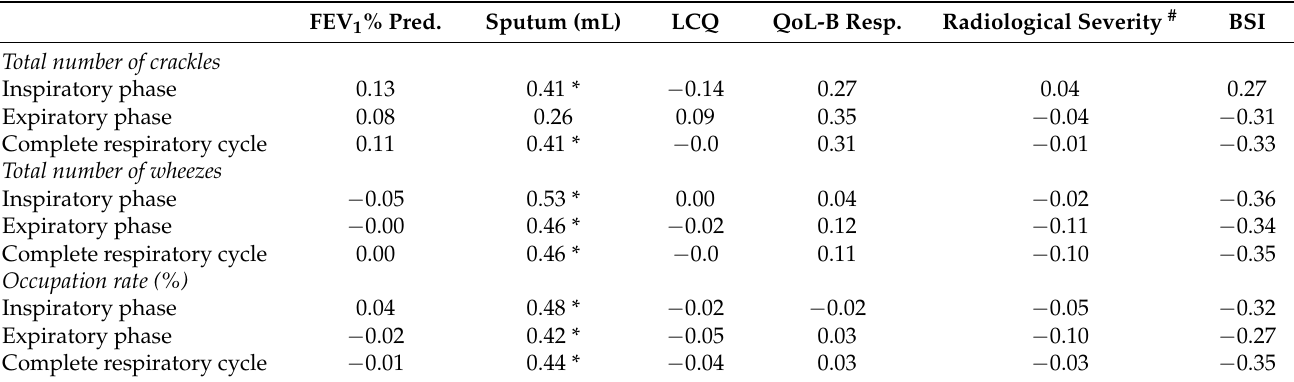
Table 3. Convergent validity. The relationship between the mean values of ARS (all chest locations) recorded in both assessment sessions and clinical measures ( n =